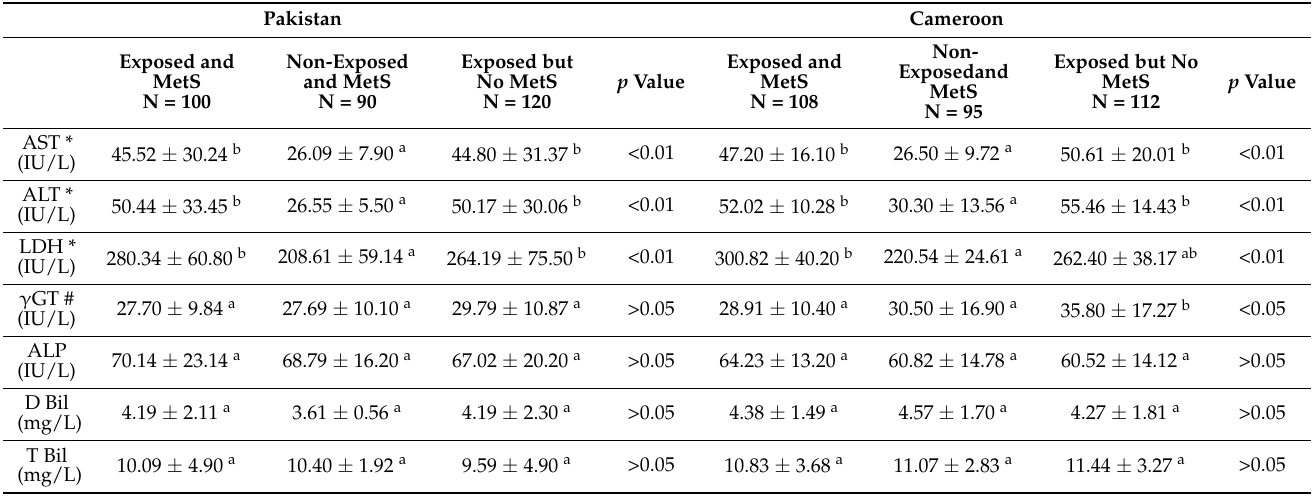
Table 4. Hepatic function variables in OPPs exposed and nonexposed groups in two populations .